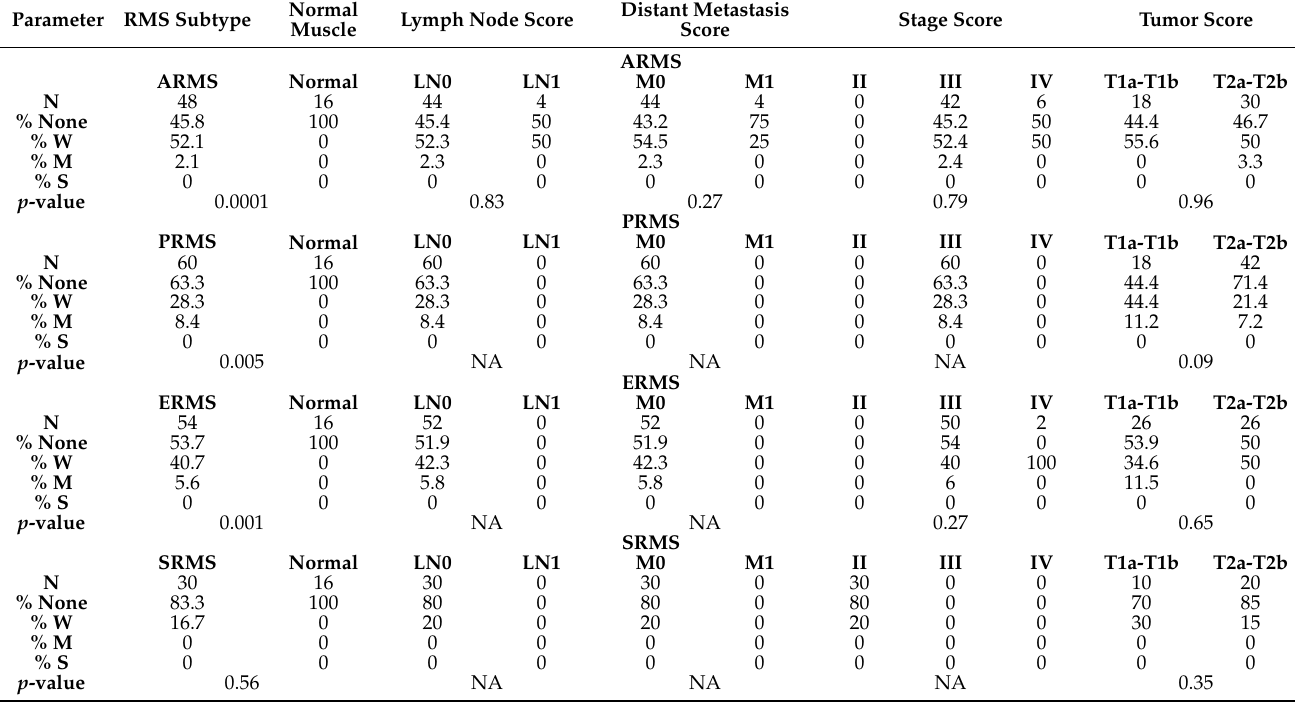
Table 3. Correlation of IRE1 α protein expression with the clinicopathological features of RMS subtypes. Parameter RMS